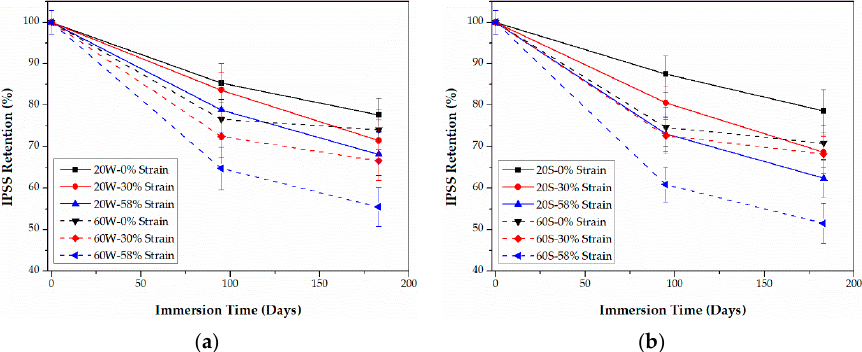
Figure 7. Retention of IPSS of epoxy-based CFRPs immersed in distilled water ( a ) and seawater ( b ) for 6 months, respectively.